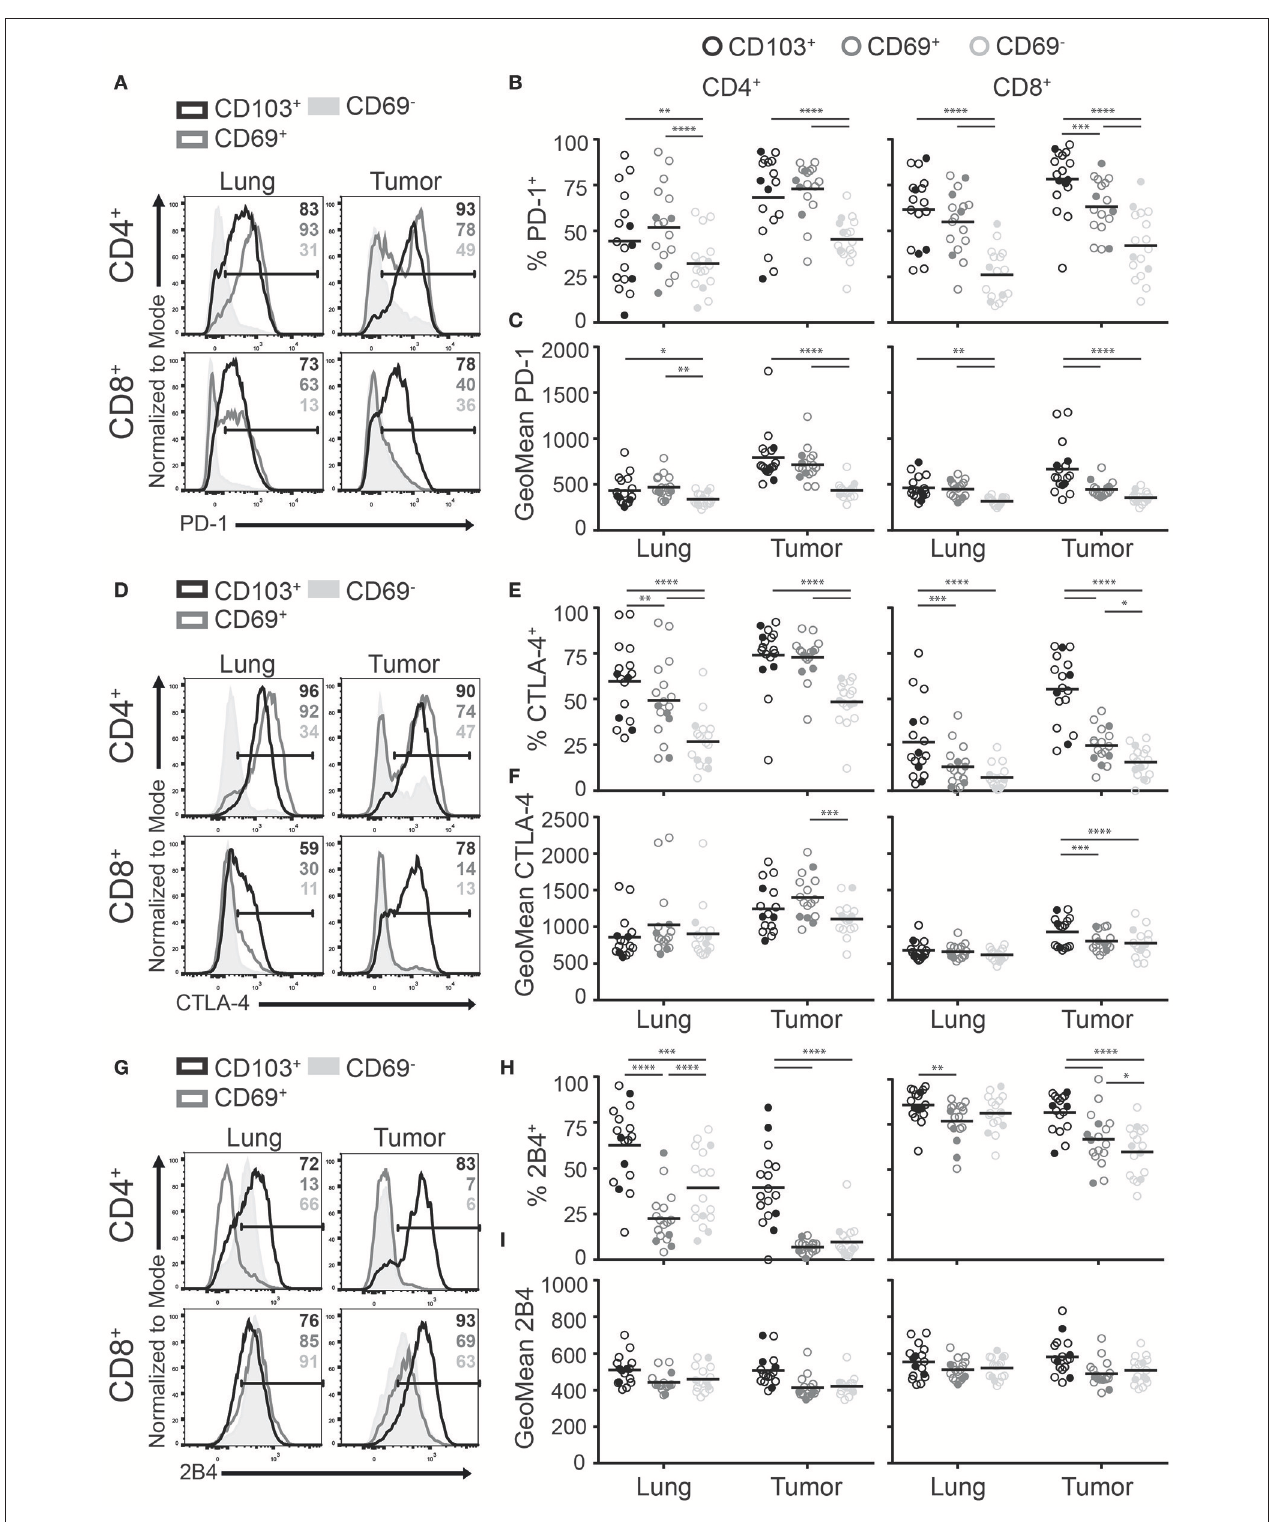
FIGURE 5 | CD103 + TILs express the highest levels of inhibitory receptors. (A–I) The expression of inhibitory receptors PD-1, CTLA-4, and 2B4 was analyzed on CD4 + and CD8 + T RM and TILs. The expression of PD-1 (A) , CTLA-4 (D) , and 2B4 (G) on lung (left panel) and tumor (right panel) on CD4 + (top panel) and CD8 + (bottom panel) T cells is shown by representative histogram overlays (maximum set to 100%) (CD103 + black, CD69 + dark gray, CD69 − solid light gray). The